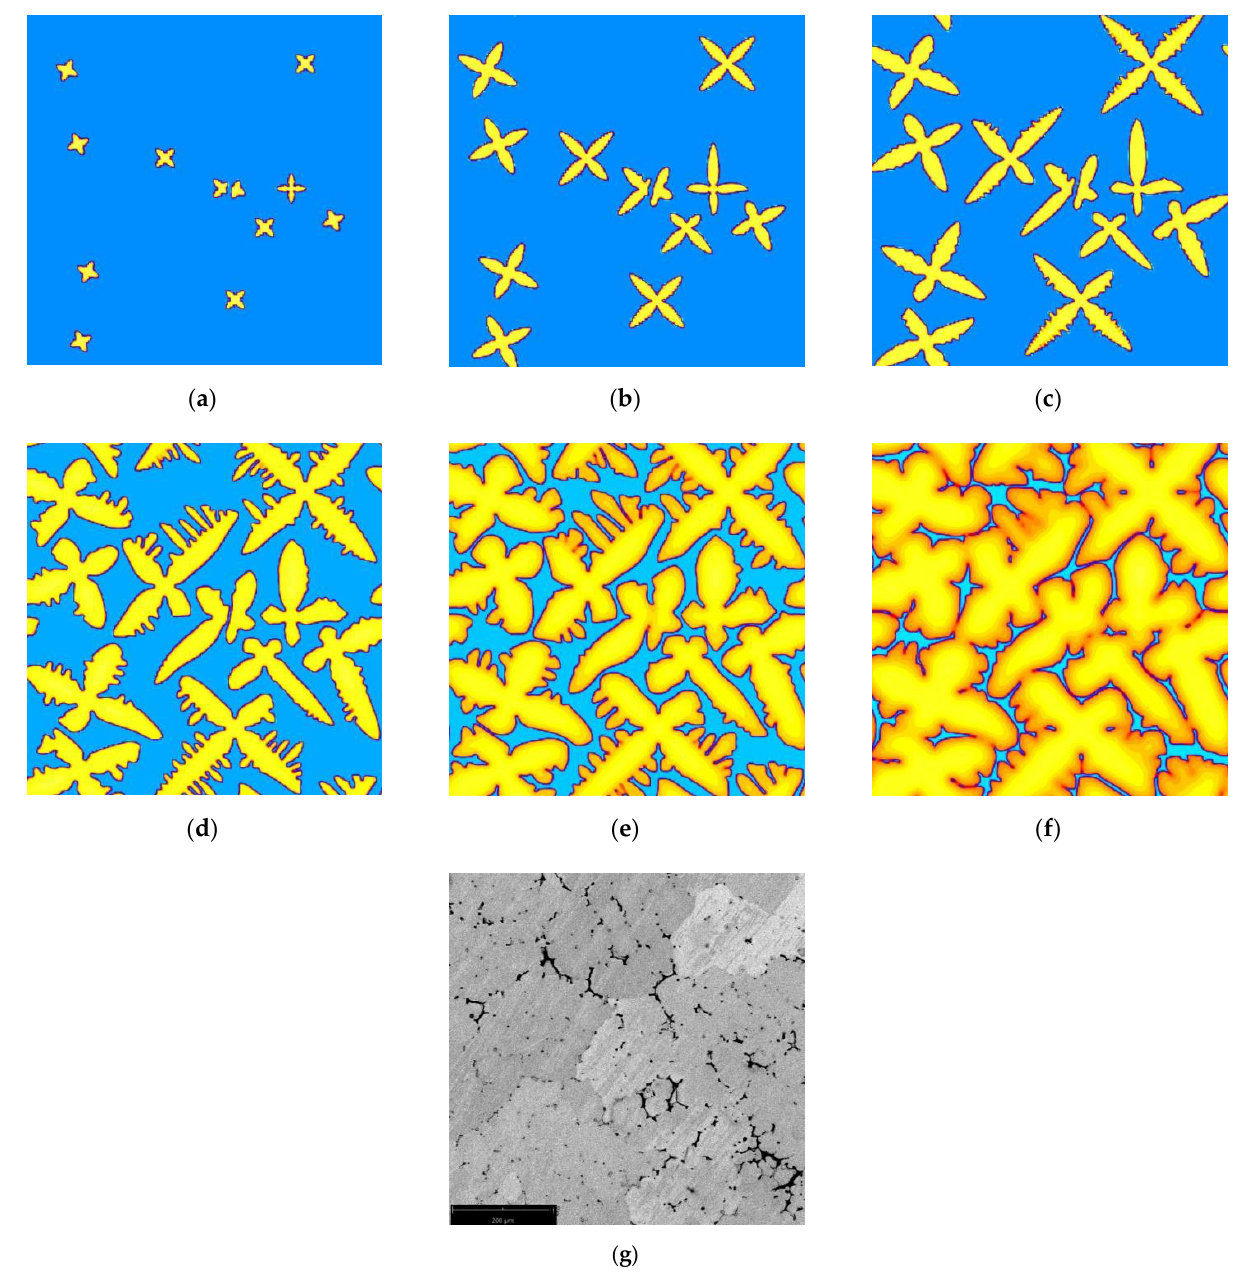
Figure 7. Multi-dendritic growth sequence in an solidifying Al + 5 wt.%. Mg alloy: ( a ) 0.02, ( b ) 0.1, ( c ) 0.2, ( d ) 0.45, ( e ) 0.7, ( f ) 0.9 of solid fraction, ( g ) actual microstructure of the Al + 5 wt.%. Mg alloy cast into a metal mold (Section 4).